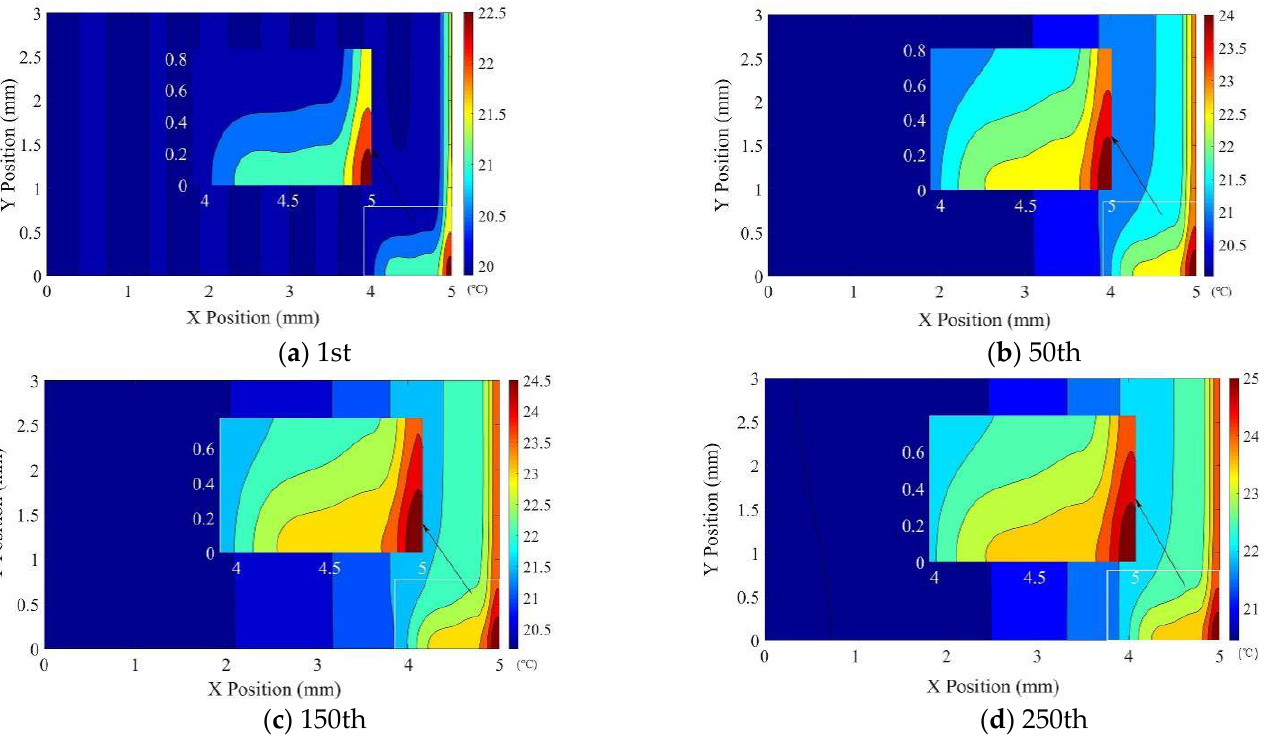
Figure 18. 3D temperature distribution of the X–Y direction section of the tool nose region.